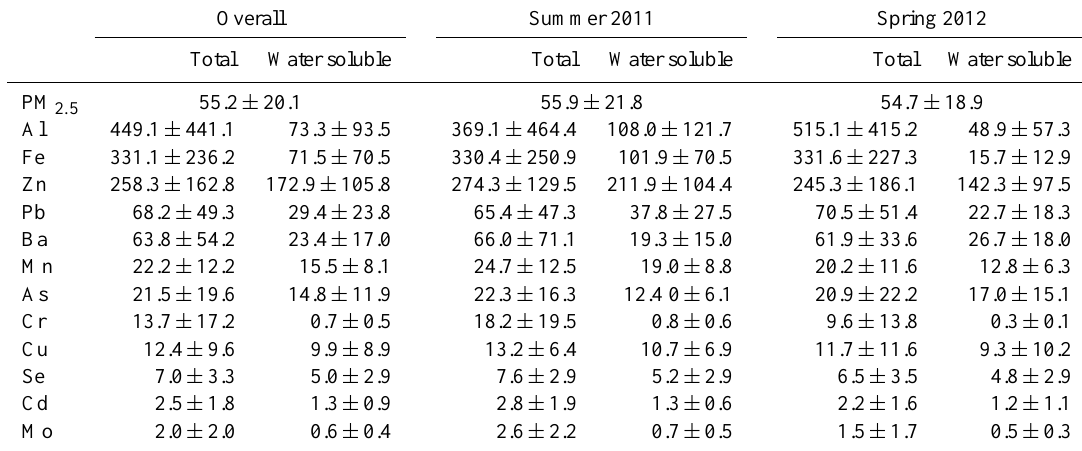
Table 1. Concentrations (mean ± SD) of PM 2 . 5 (µgm − 3 ) and trace elements (ngm − 3 ) including total and water-soluble fraction at Mt.